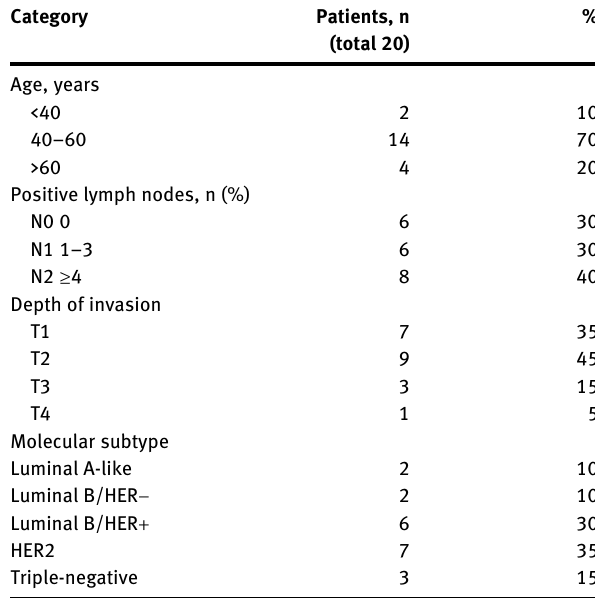
Table  : Relationship between pathological